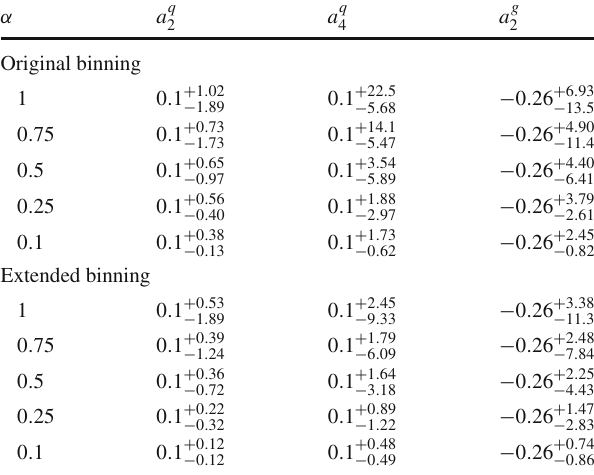
Table 2 Estimate of the determination uncertainty on the leading-twist parameters a n from the pseudo-data (see text). The parameter α is the relative size of the systematic uncertainty with respect to the